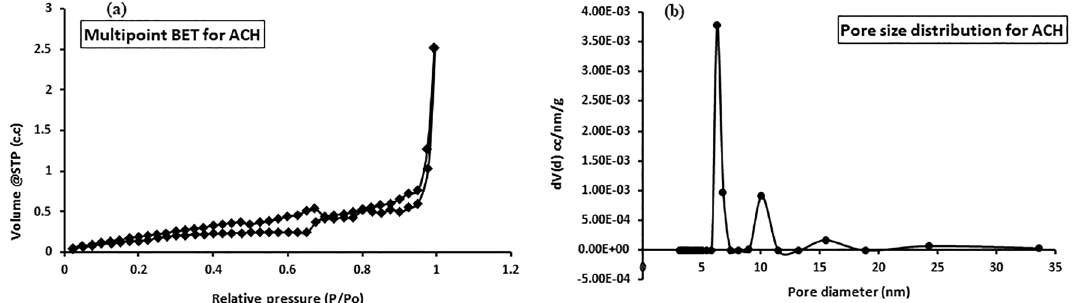
Figure 1. Nitrogen adsorption–desorption isotherm ( a ) and pore size distribution of activated hydrochar ( b ).